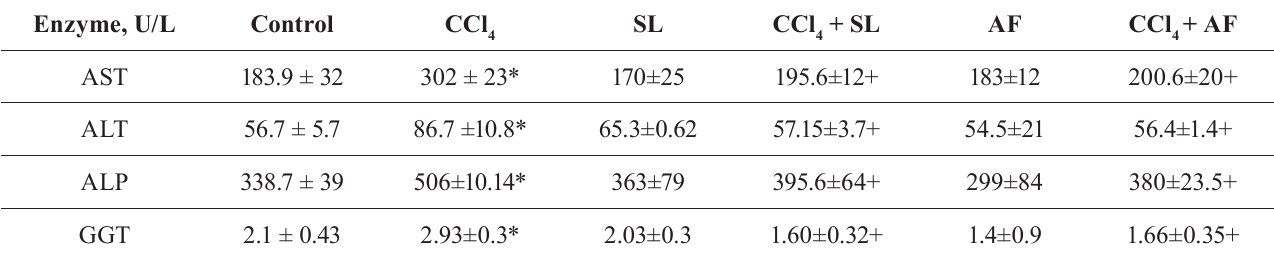
-induced alterations in serum enzyme activities 4